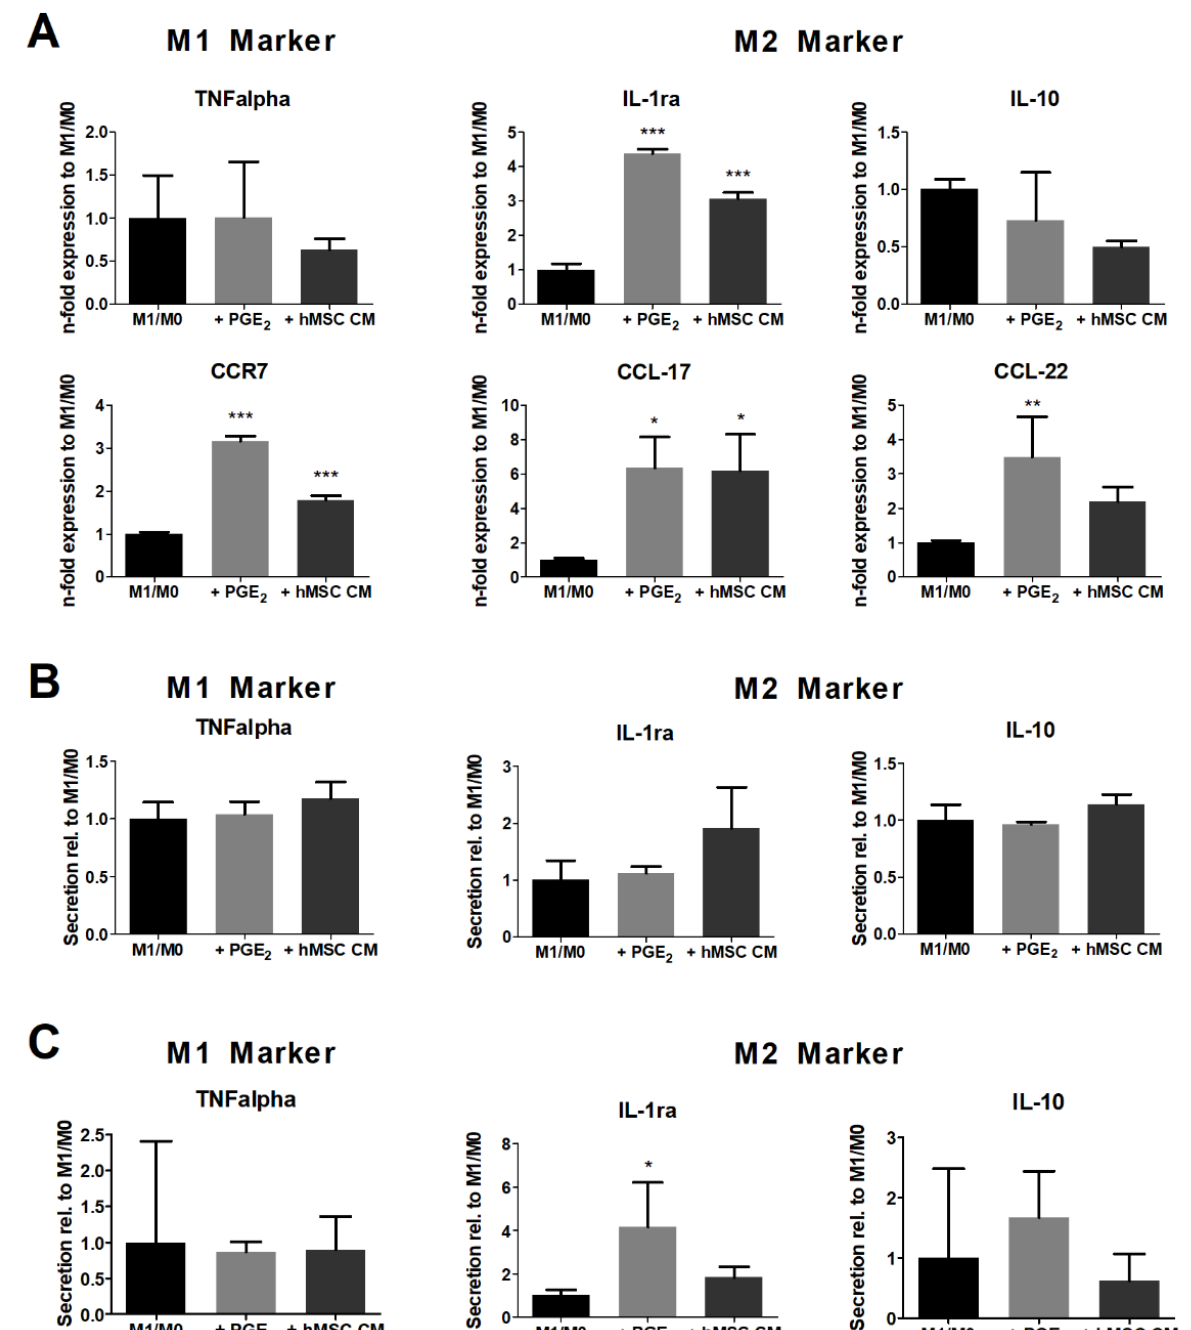
Figure 3. hMSCs modulate the gene expression of M1-polarized macrophages but fail to modulate cytokine secretion. Polarized M1 macrophages were incubated with the control medium (M1/M0 , black bars), the spiked medium containing 5 ng/mL PGE 2 (+PGE 2 ), light gray bars), or the conditioned medium of M1-primed hMSCs (+hMSC CM, dark grey bars) for 24 h and compared to the control. ( A ) THP-1 gene expression fold increase upon incubation without or with PGE 2 or hMSC CM. Displayed are proinflammatory genes, TNFalpha and CCR7, and anti-inflammatory genes, CCL-17, CCL-22, IL-1ra, and IL-10. ( B ) Cytokine secretion of THP-1 macrophages upon incubation of polarized M1 macrophages without or with PGE 2 or hMSC CM. Displayed are proinflammatory cytokine, TNFalpha, and anti-inflammatory cytokines, IL-1ra and IL-10. ( C ) Cytokine secretion of primary macrophages (hMDMs) upon incubation of polarized M1 macrophages without or with PGE 2 or hMSC CM. Statistical significance was determined against the control using one-way ANOVA and Dunnett’s post hoc test. * = p < 0.05; ** = p < 0.01; and *** = p < 0.001. n =